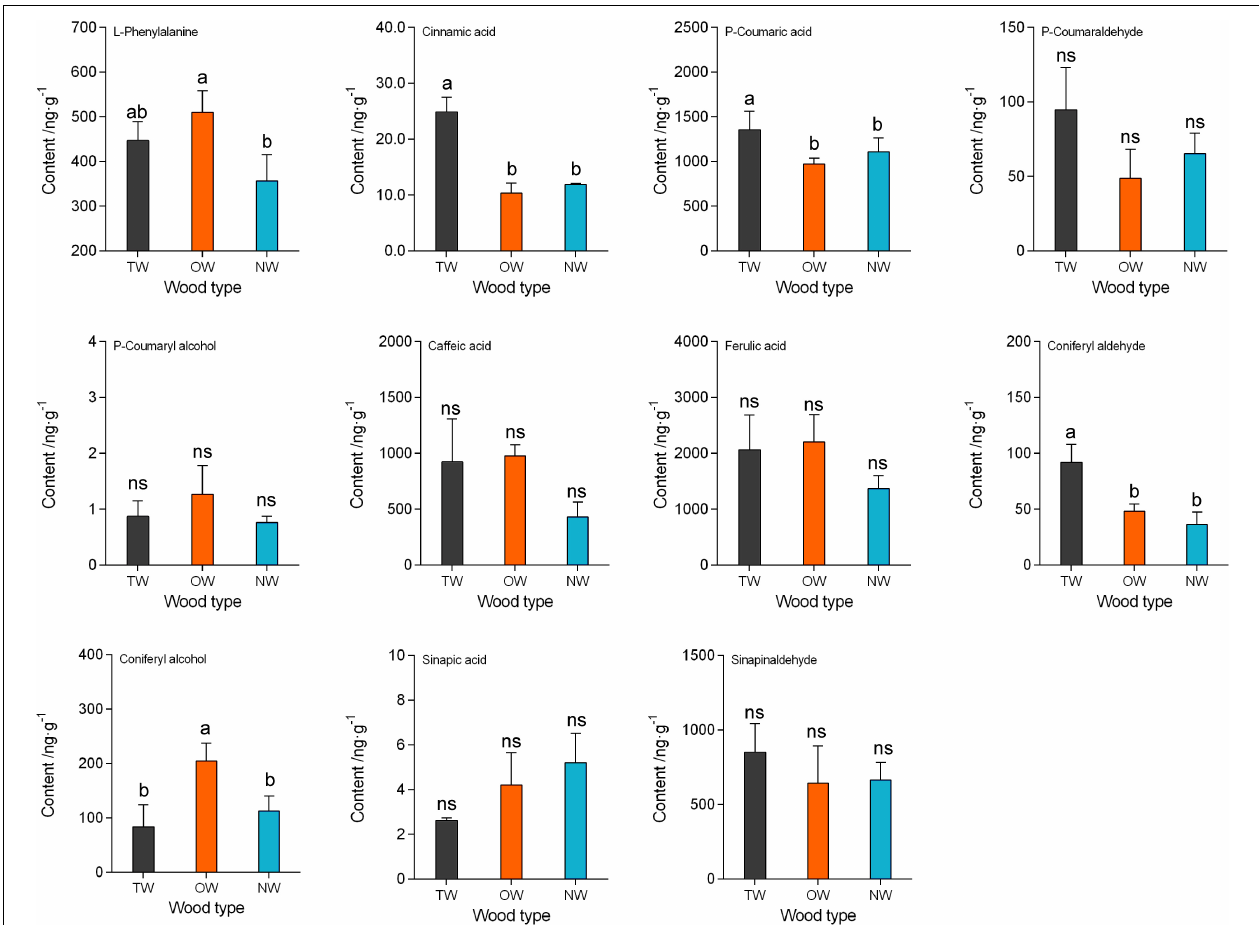
FIGURE 4 | The contents of metabolites in lignin monomer biosynthesis in tension wood (TW), opposite wood (OW), and normal wood (NW). Duncan’s method was used for multiple comparisons. Different lowercase letters indicate a 5% significant difference. ns, not